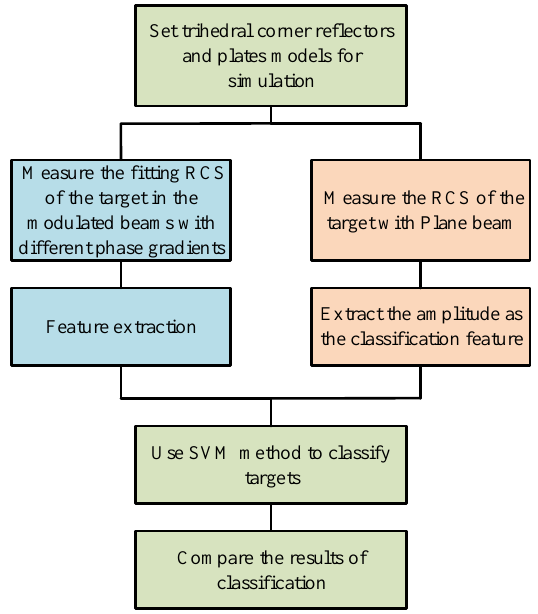
Figure 7. The classification